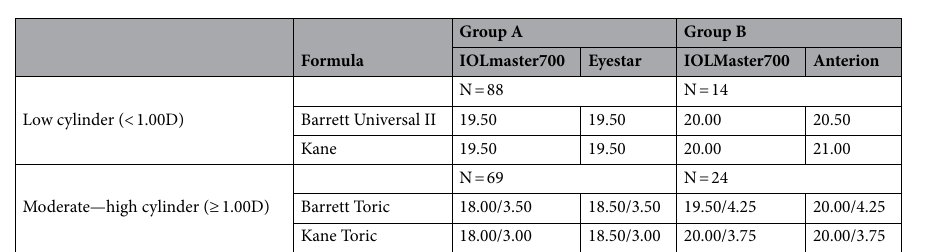
Table 6. Suggested IOL power (diopters) stratified by cylinder